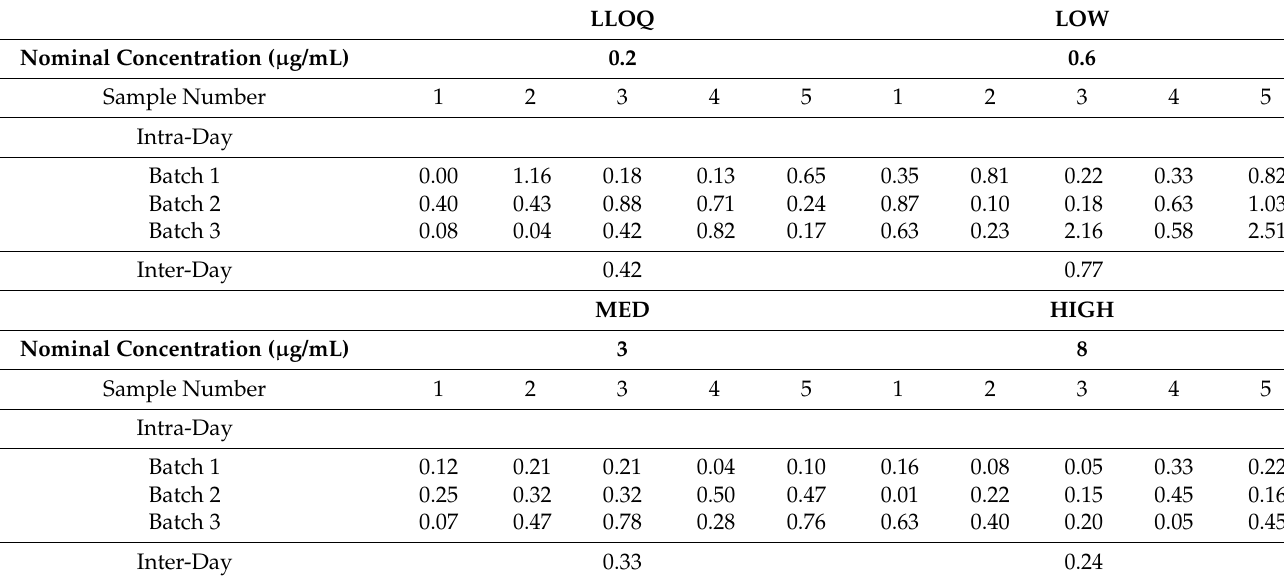
Table 4. Intra-day and inter-day precision (CV %) for the quality controls. LLOQ